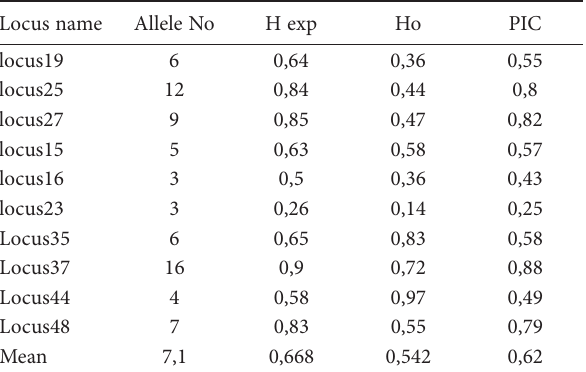
Table 2. SSR locus name, number of alleles (No), observed (Ho) and expected heterozygosities(He), polymorphic information con- tent (PIC) of 10 microsatellite loci in a sample of 35 accessions of Chamaerops humilis